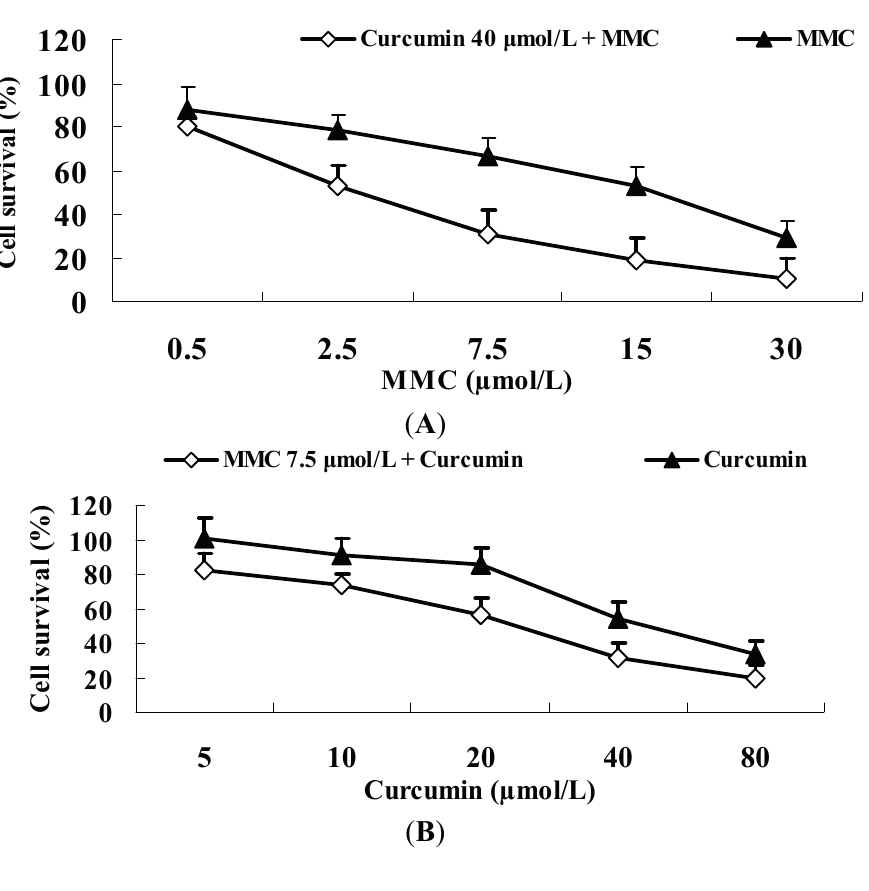
Figure 6. Sensitivity of breast cancer MDA-MB-231 cells to MMC and MMC plus curcumin. MTT assay was performed to determine cell number as described in Material and Methods. ( A ) MDA-MB-231 cells were treated with 0.5, 2.5, 7.5, 15 and 30 µmol/L MMC with or without 40 µmol/L curcumin for 48 h; ( B ) MDA-MB-231 cells were incubated in 5, 10, 20, 40 and 80 µmol/L curcumin with or without 7.5 µmol/L MMC for 48 h. Values are mean ± SE from three independent